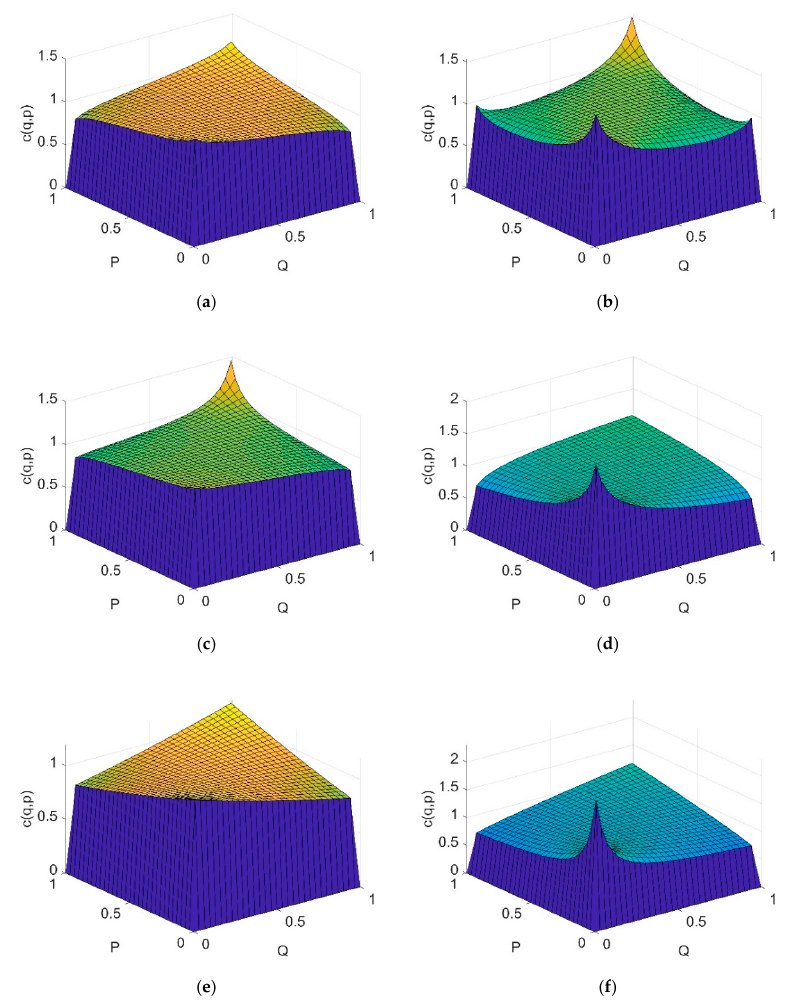
Figure 6. Probability density distribution. ( a ) Gaussian copula; ( b ) t-copula; ( c ) Gumbel copula; ( d ) Clayton copula; ( e ) Frank copula; ( f ) m-copula.